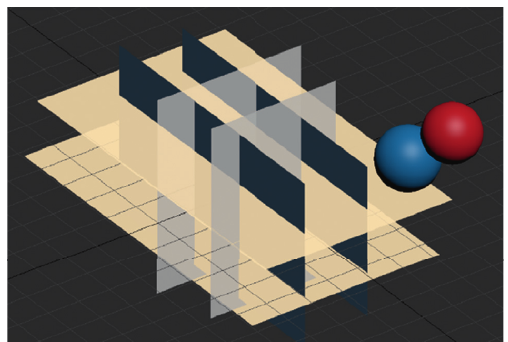
Figure 11: MBR model in Example 1(a).